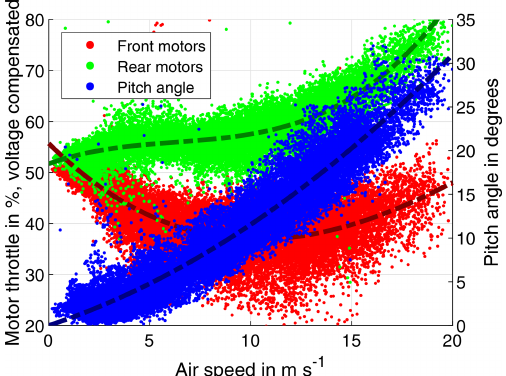
Figure 8. Motor throttle (front and rear motor pairs) and pitch angle vs. flight speed. The spread can be explained by the control loops working against external disturbances during free flight in windy conditions. Rear motors generally need to provide more thrust than the front motors to compensate for a pitch-up moment. This effect results from a combination of uneven lift distribution of the rotors in forward flight and gyroscopic precession (US Department of Trans- portation, 2019). The additional drag of the sonic anemometer am- plifies the pitch-up moment which is compensated by higher throttle on the rear